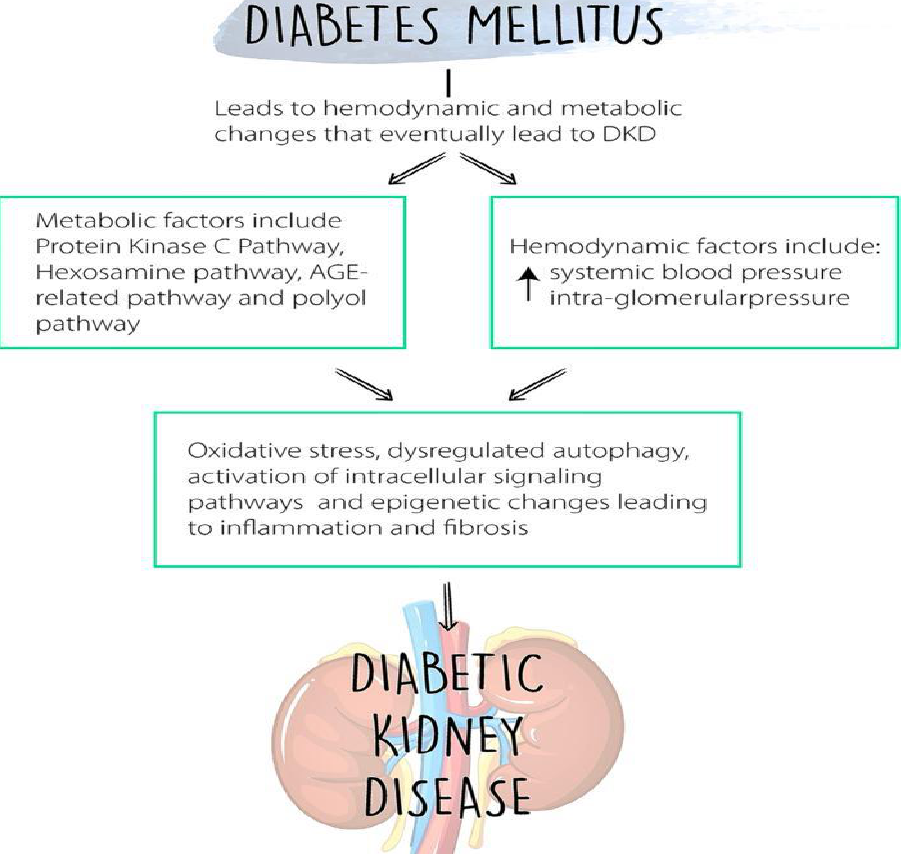
Figure 1. Diabetes mellitus leads to both hemodynamic factors, which include increased blood pres- sure and intraglomerular pressure, and metabolic factors (including protein kinase C, Hexosamine, polyol and AGE-related pathways leading to ROS and activation of signaling pathways leading to inflammation and DKD.